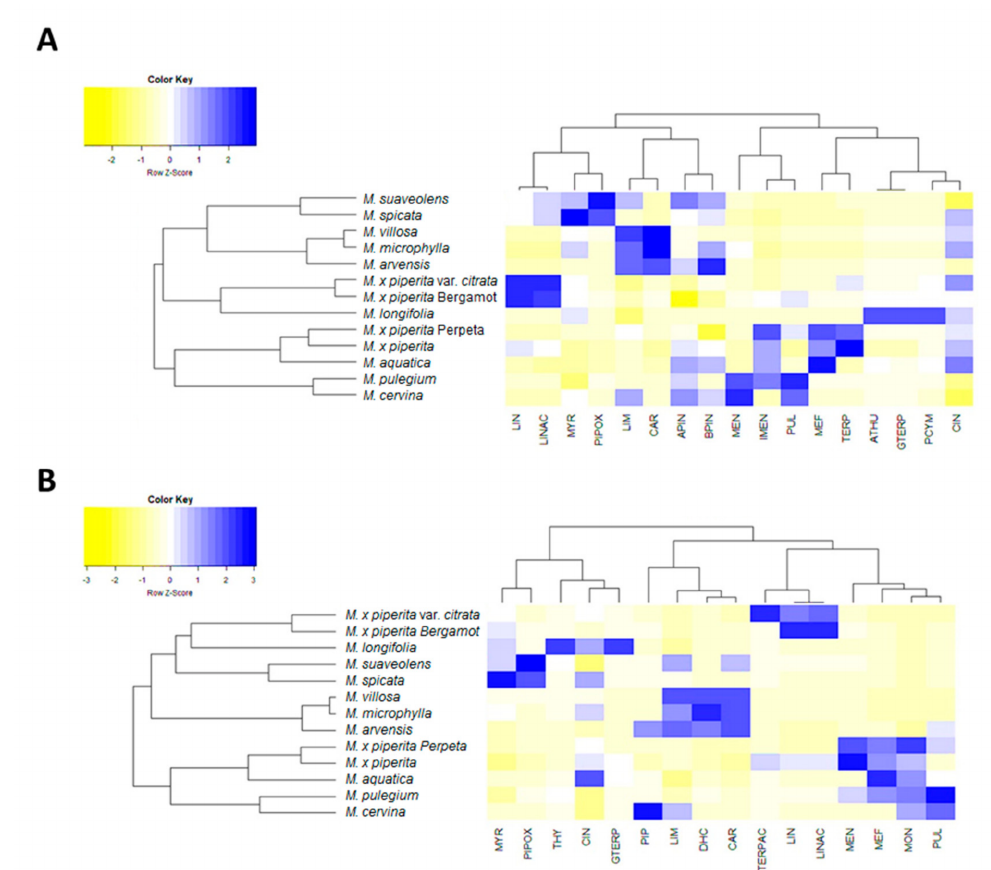
Figure 4. Heat maps of the headspaces ( A ) and essential oils ( B ) in thirteen different Mentha species. LIN: linalool; LINAC: linalyl acetate; MYR: myrcene; PIPOX: piperitenone oxide; LIM: limonene; CAR: carvone; APIN: α -pinene; BPIN: β -pinene; MEN: menthone; IMEN: isomenthone; TERP: terpinen-4-ol; ATHU: α -thujene; GTERP: γ -terpinene; PCYM: p -cymene; CIN: 1,8-cineole; THY: thymol; PIP: piperitenone; DHC: dihydrocarvone; TERPAC: α -terpinyl acetate; MEH: menthofuran; MON: menthone; PUL: